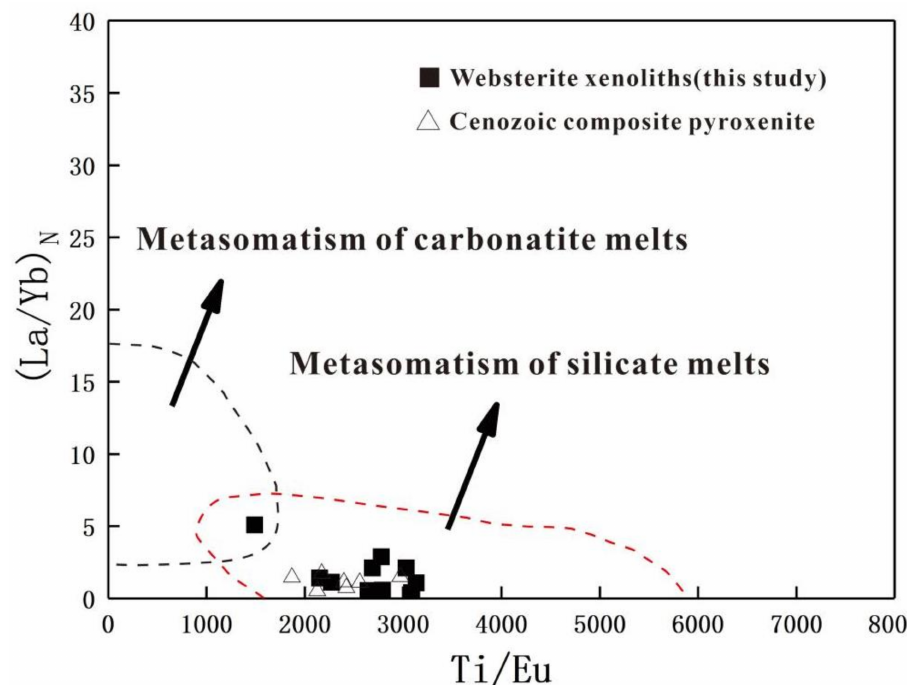
Figure 13. Discrimination diagram of metasomatism. Note: Cenozoic composite pyroxenite data are sourced from Liu et al.